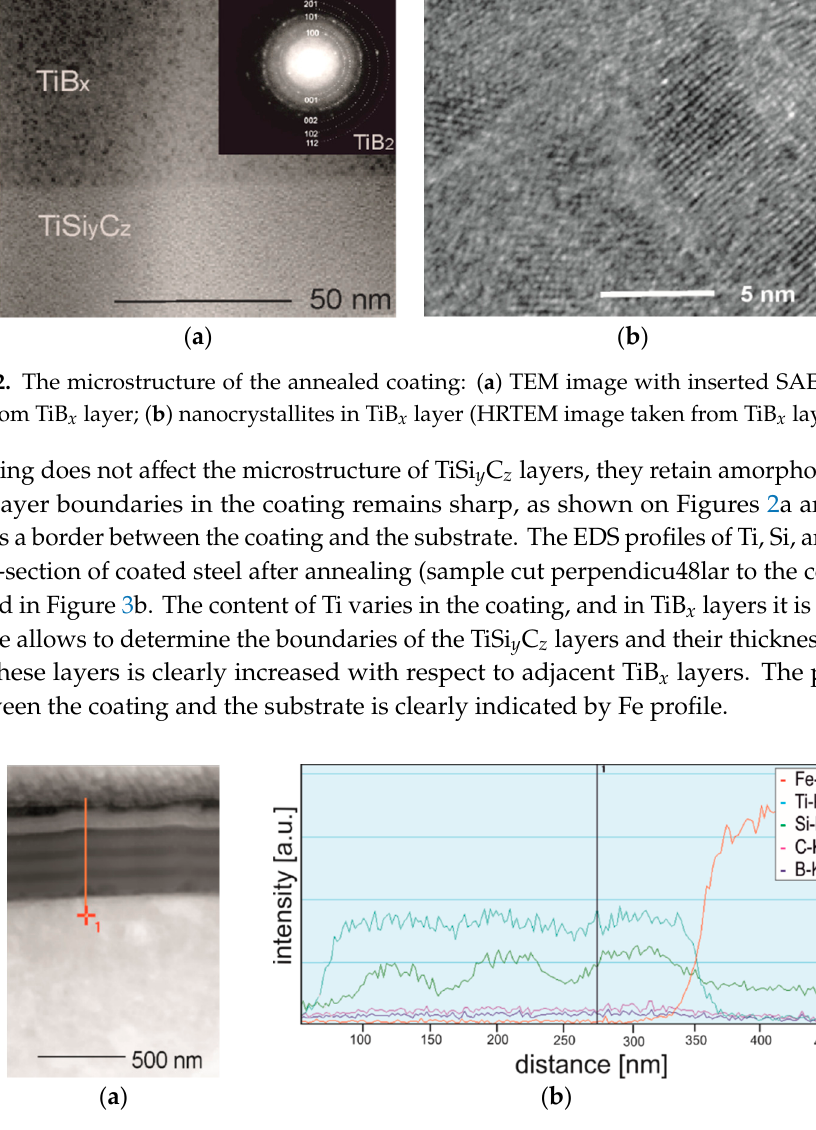
Figure 3. ( a ) STEM image of the microstructure of the coating after annealing with marked line for EDS analysis; ( b ) EDS concentration profiles of Ti, Si, C, B, O and Fe, registered across the thickness of the multilayer coating on M2 steel substrate.